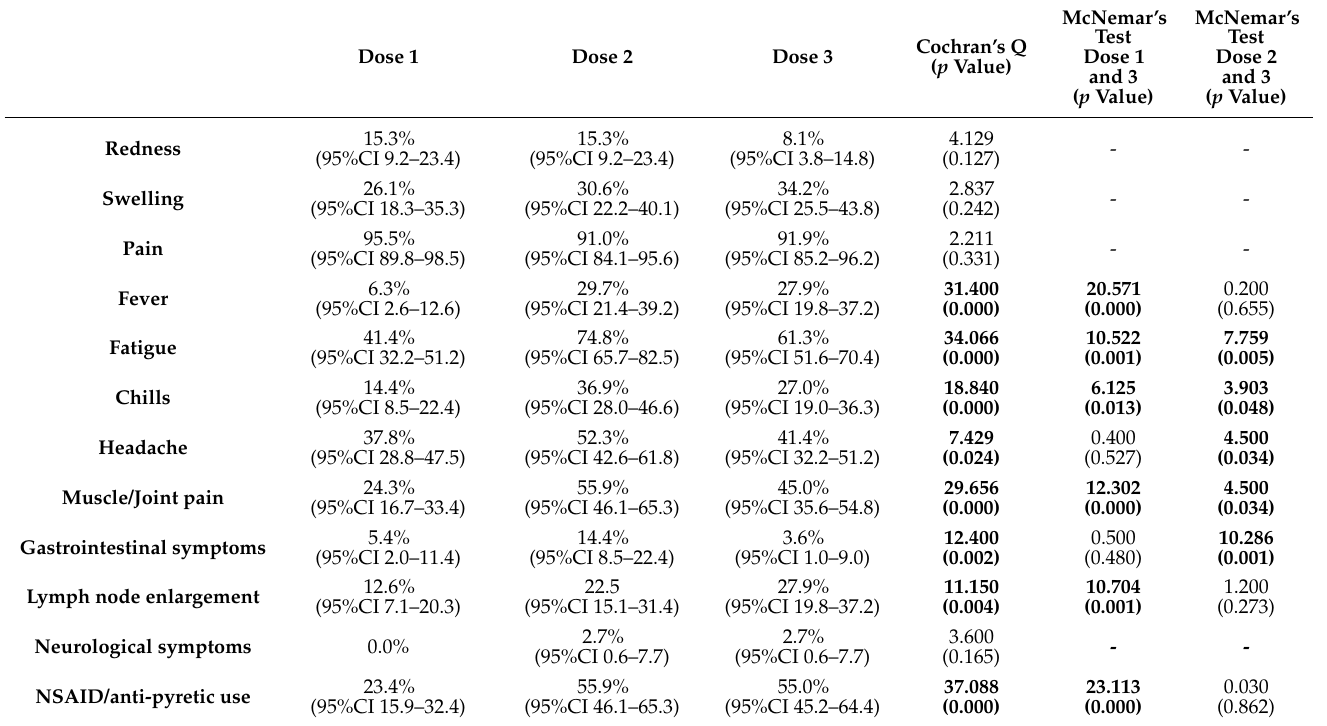
Table 4. Differences in reporting of systemic adverse reactions and medication use in the 7 days following each of the three vaccine doses